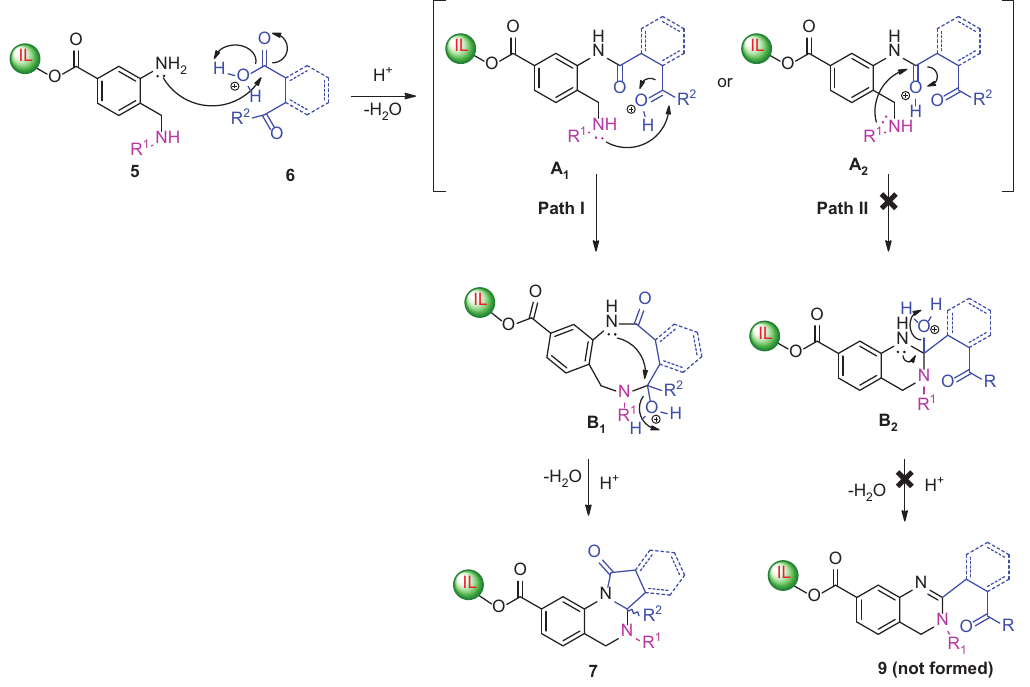
ILOH Scheme 2 Synthetic route for IL-bounded diamine 5 . NH 2 H NaOMe Scheme 3 Acid catalyzed synthesis of isoindoloquinazoline 8 . O O OIL NH 2 O OR 2